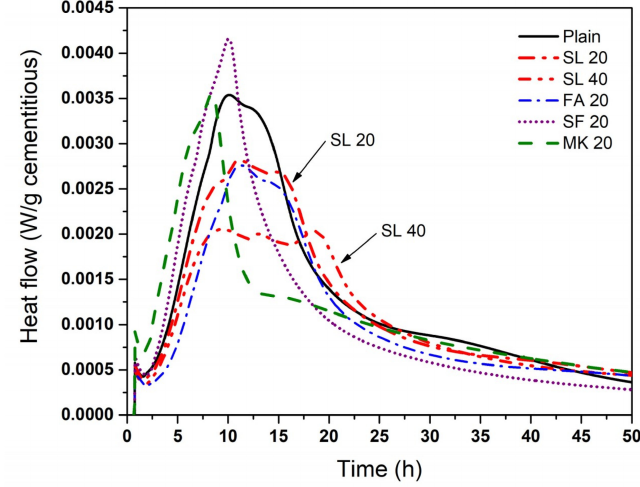
Figure 5. Heat flow of cement paste with various SCMs at 23 ◦ C.